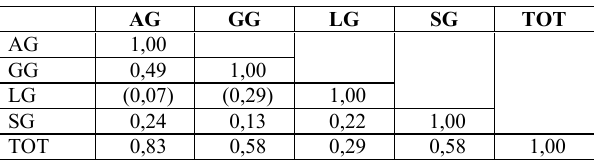
Table 5: Correlation of frequencies of critical